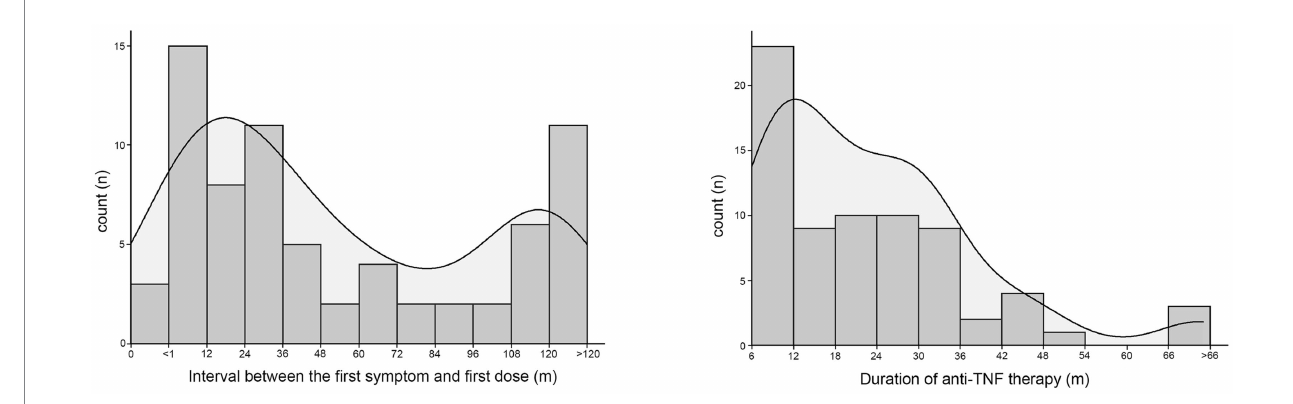
FIGURE 2 The number of patients who received anti-TNF therapy were divided by an interval of one year according to the interval between the first onset of symptoms and the first dose of biologics or the dosing time of biologics. The corresponding density curve are illustrated in each figure.